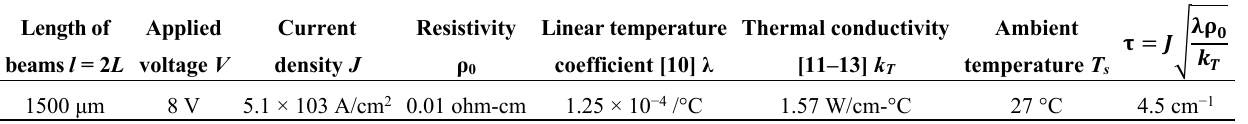
Table 1. Material properties of silicon wafer and detailed design of proposed structure. Length